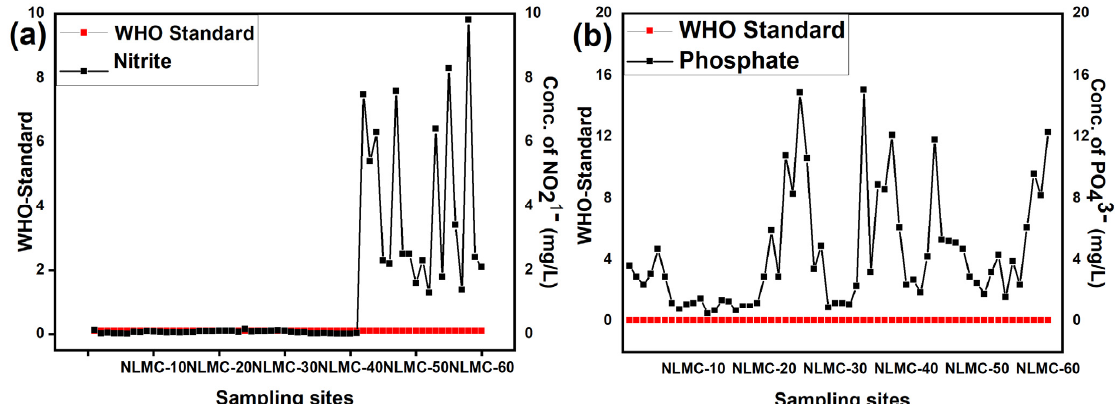
Figure 3. Shows the plot between the high concentrations of NO 21 − vs. the standard values by the WHO at different sampling sites of the district of Neelam, AJK ( a ), ( b ) the concentration of PO 4 3 − against the WHO